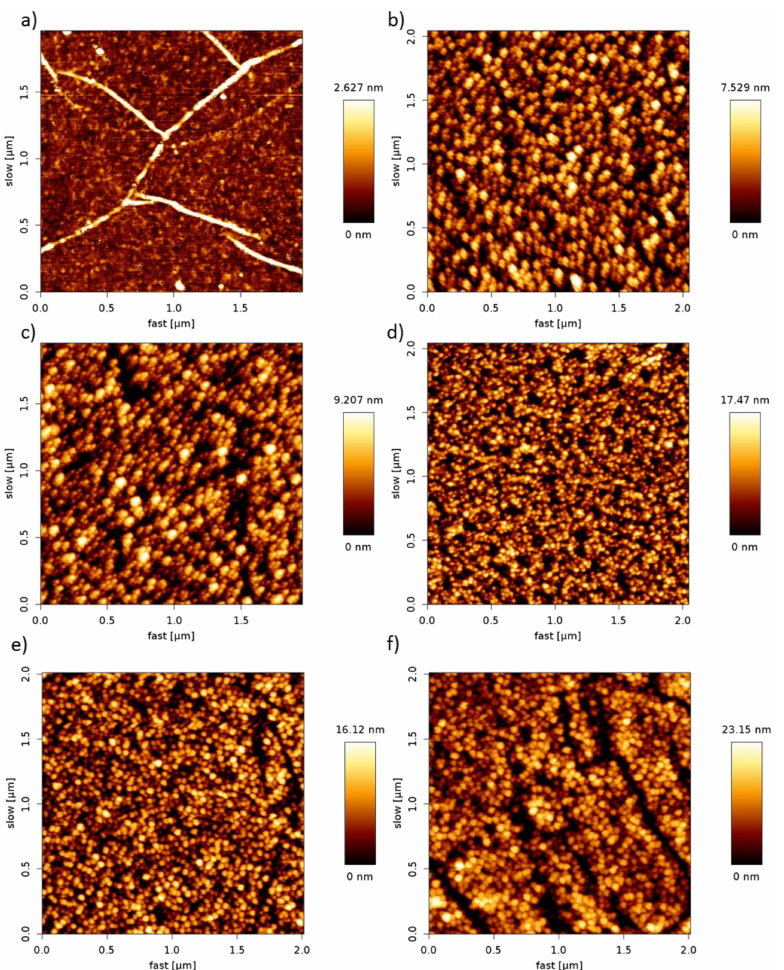
Figure 2. AFM images of pDAN layers deposited on CVD graphene surface at different number of cycles: ( a ) 0, ( b ) 5, ( c ) 10, ( d ) 25, ( e ) 50, and ( f ) 75 cycles, respectively, at a scan rate of 50 mVs − 1